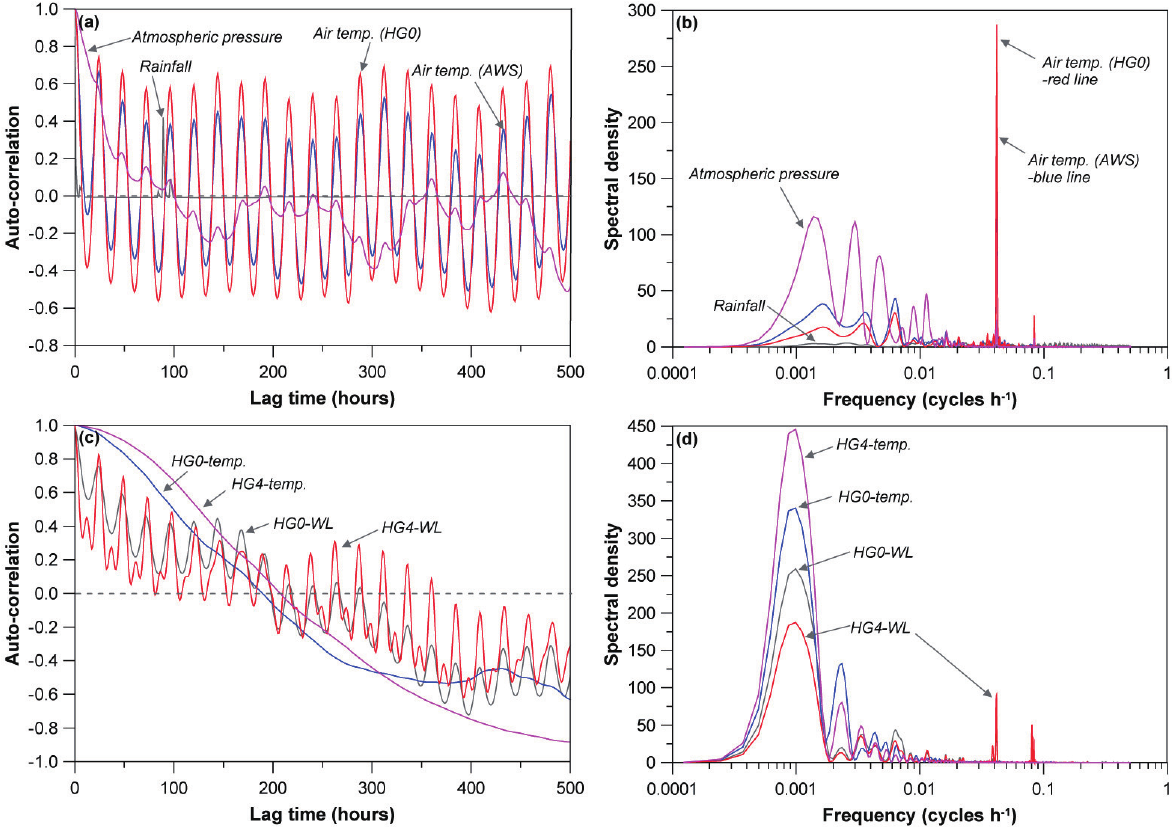
Figure 6. ( a ) Auto-correlation (truncation = 500 hours) and ( b ) spectral density functions for air temperature, rainfall, and air pressure; ( c ) Auto-correlation (truncation = 500 hours) and ( d ) spectral density functions for groundwater level and temperature. The dotted lines represent that auto-correlation becomes a null